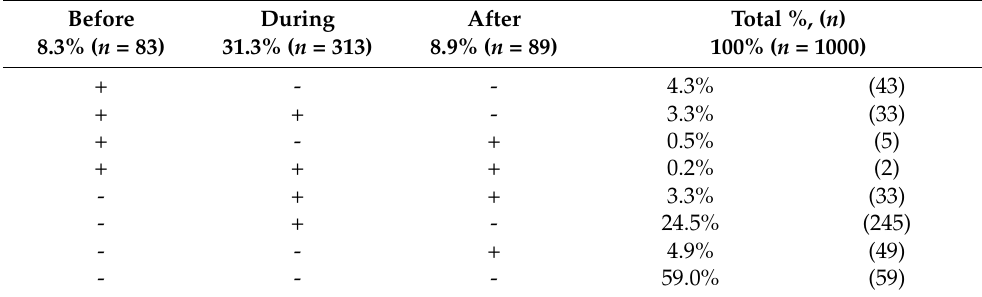
Table 2. Combined reported antibiotic use and antibiotic prescription throughout the course of